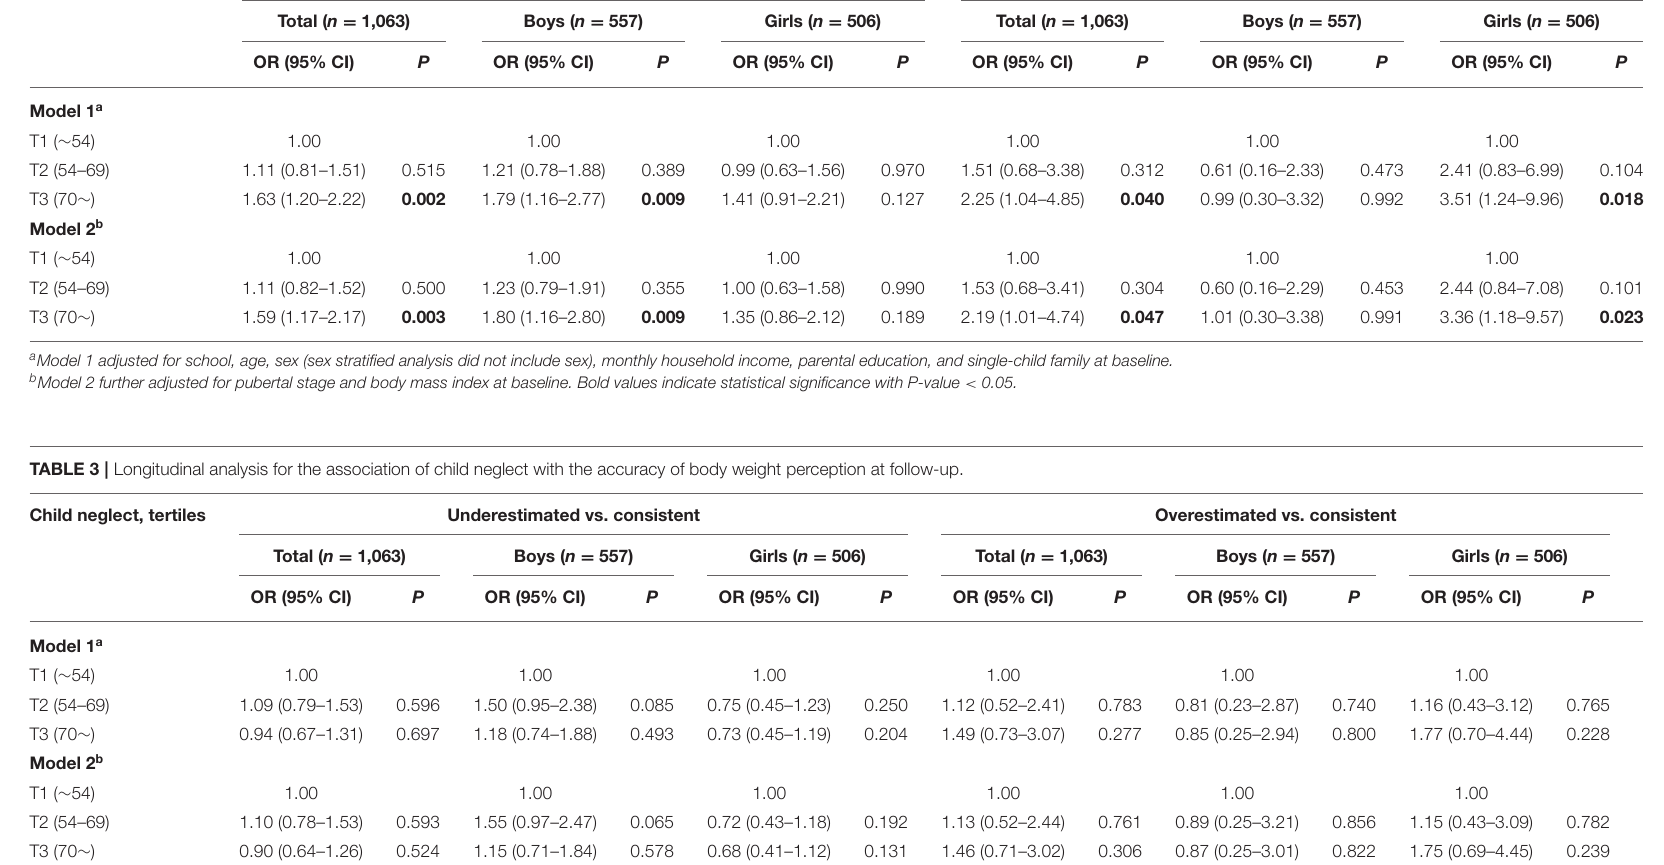
TABLE 2 | Cross-sectional analysis for the association of child neglect with the accuracy of body weight perception at baseline. Child neglect, tertiles Underestimated vs. consistent Overestimated vs. consistent